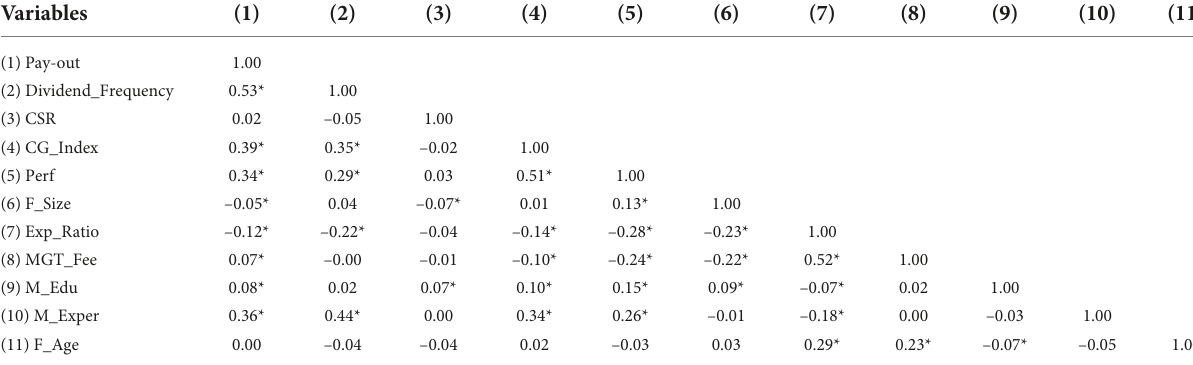
TABLE 3 Correlation matrix.